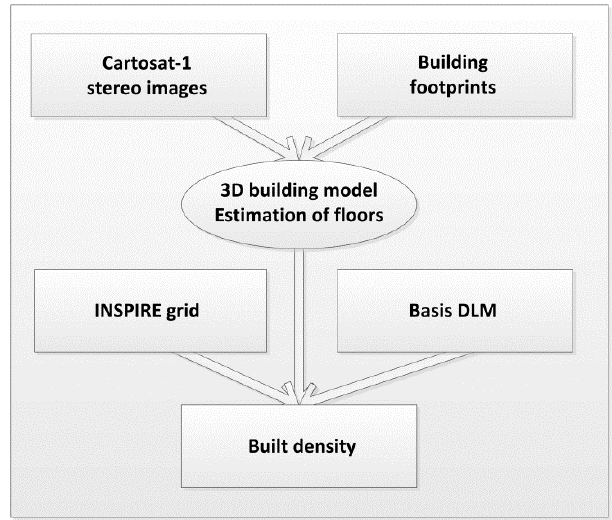
Figure 1. Flowchart of the steps performed for modeling the built densities.